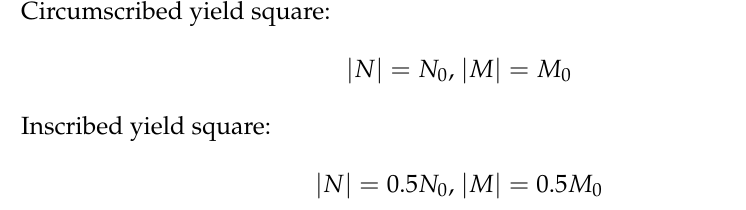
Figure 4. Yield condition between the bending moment and the axial force.